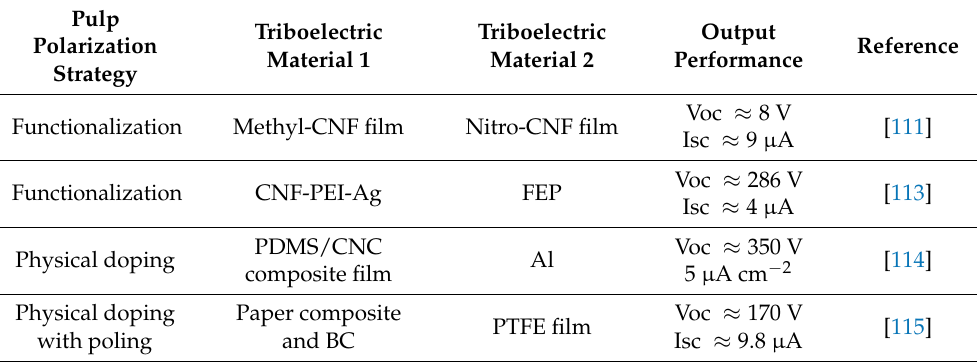
Table 8. The first nanocellulose-based TENG [106]. Examples of TENGs based on CNCs, CNFs, and